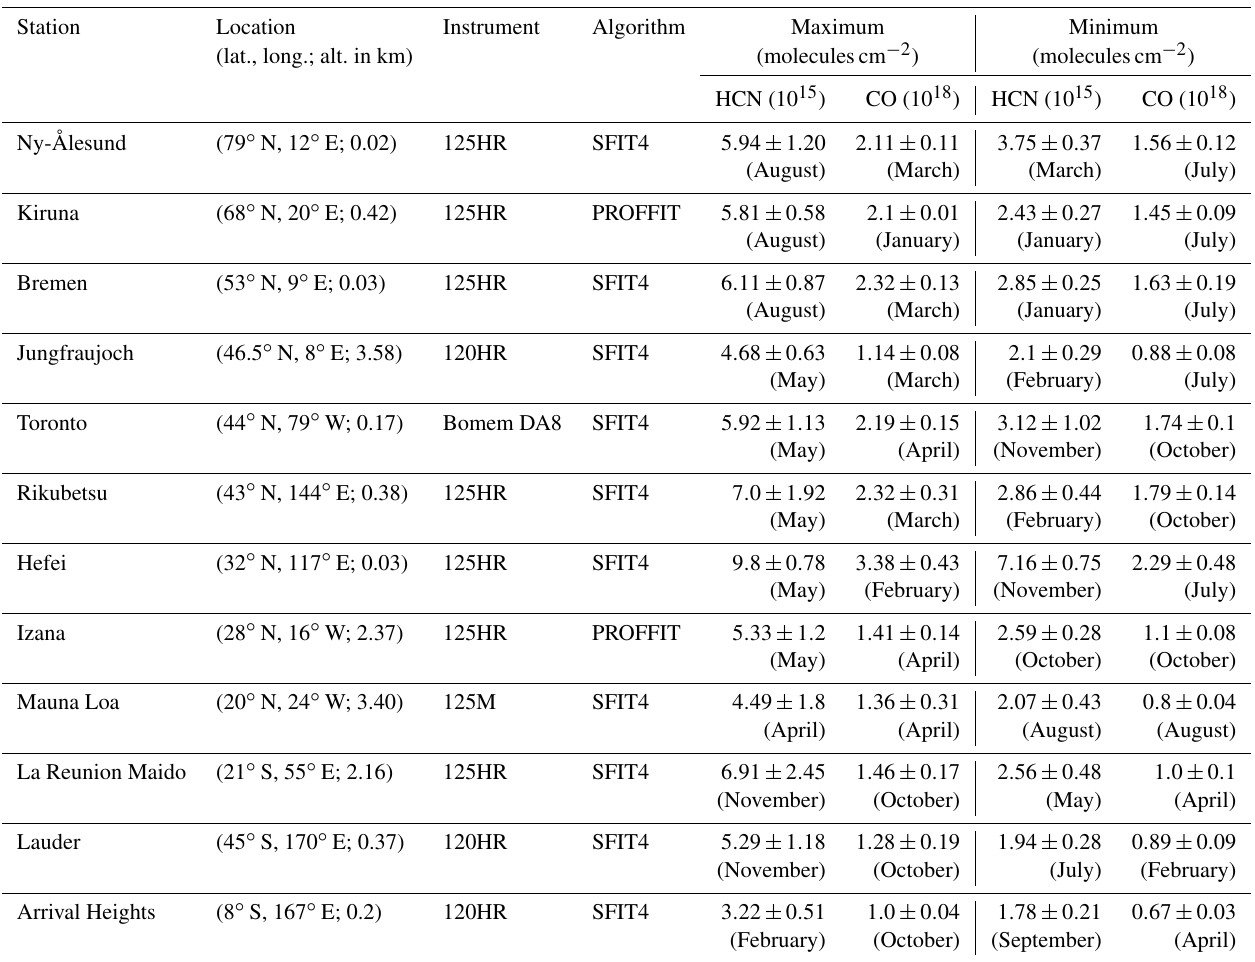
Table 4. Tropospheric HCN and CO columns at Hefei (32 ◦ N), China, from 2015 to 2018 alongside those of the NDACC FTIR stations. All stations are organized as a function of decreasing